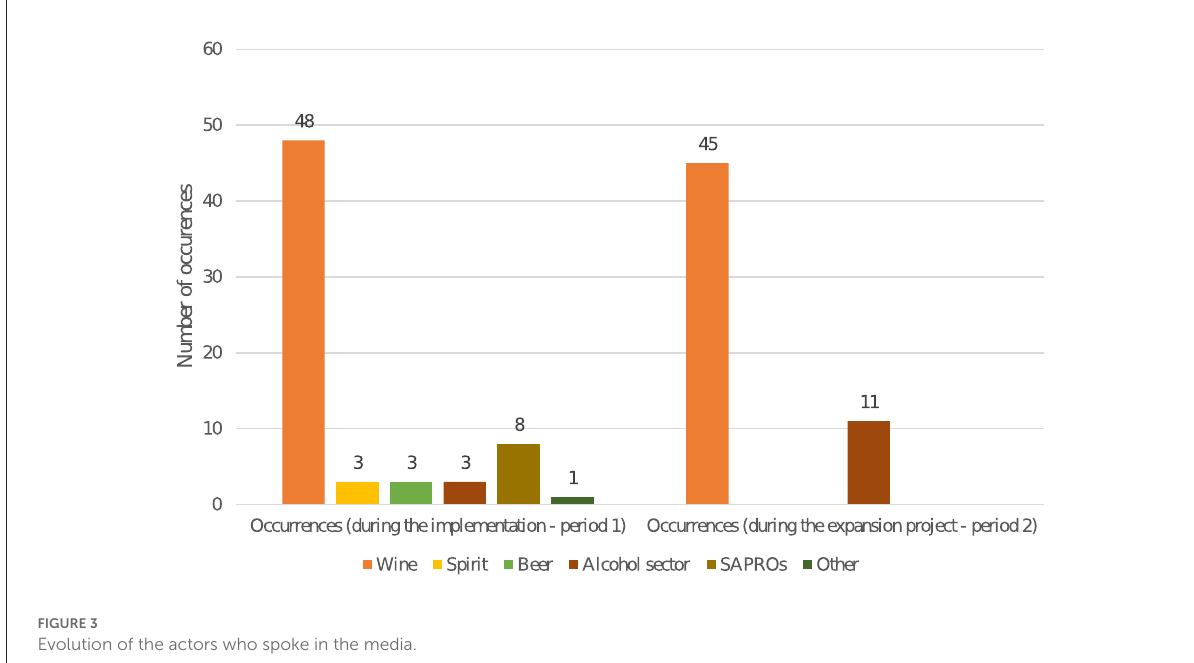
FIGURE3 Evolution of the actors who spoke in the